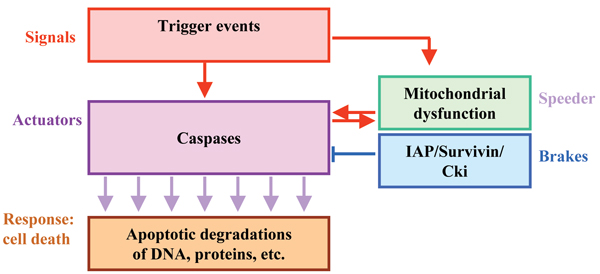
The basic blueprint of neuronal apoptosis showing the different modules and how they are interconnected by positive and negative feed-backs.